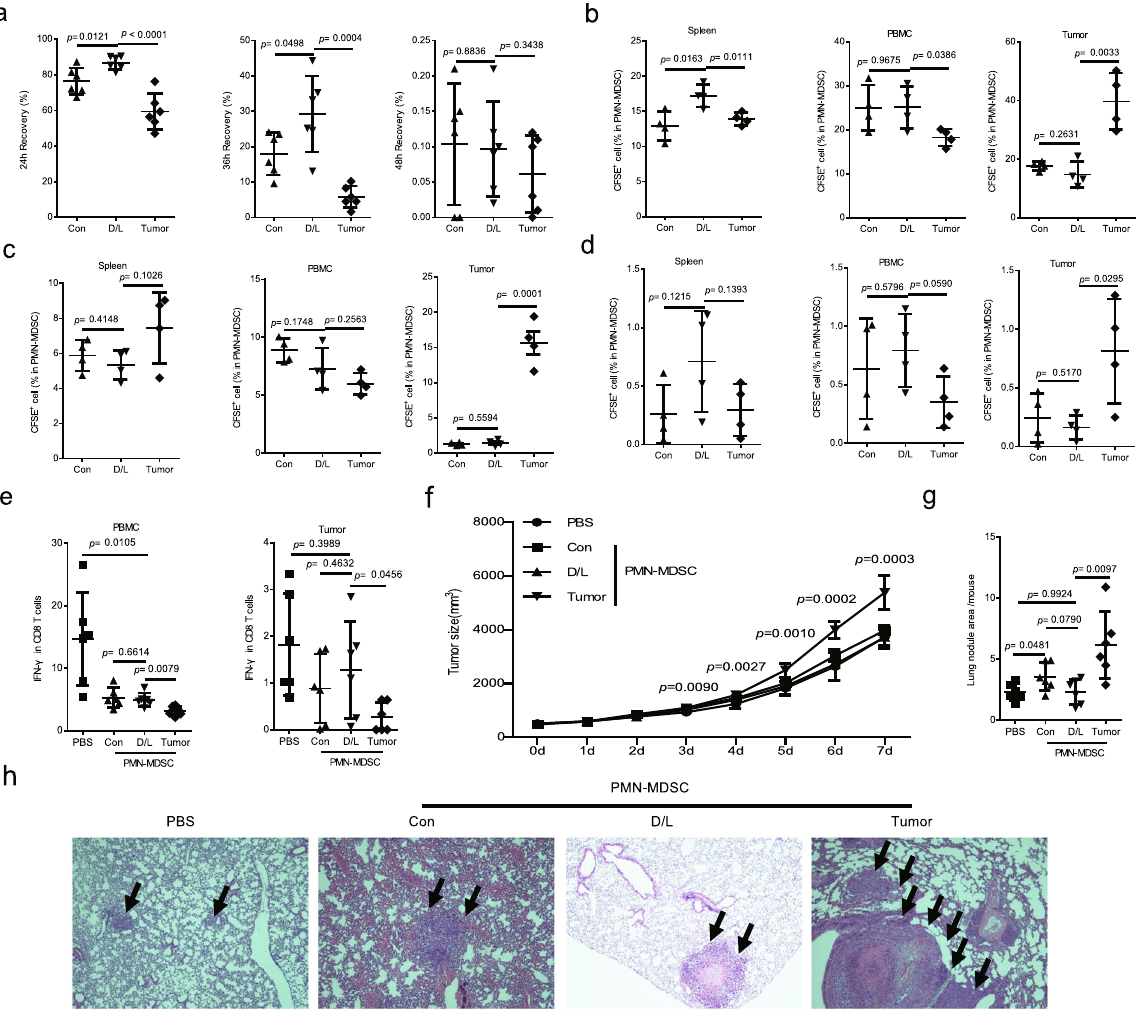
Fig. 4 DXM/lactoferrin PMN-MDSCs presented improved survival capability, less tumor homing tendency and negative tumor promotive effects compared to tumor PMN-MDSCs. a Recovery of PBS (Con) or DXM/lactoferrin (D/L) in vitro from mouse BM cells and PMN-MDSCs from B16 tumor- bearing mice after 24, 36, and 48 h of culture in complete media without cytokines ( n = 6 biologically independent samples). Puri fi ed cells (2 × 10 5 ) were plated at the beginning of culture. Transfer/host PMN-MDSC ratio in spleen, PBMC, and tumor 1 ( b ), 2 ( c ) and 3 ( d ) days after i.v. injection of CFSE- labeled PBS (Con) or D/L in vitro from mouse spleen cells and PMN-MDSCs from B16 tumor-bearing mice into tumor-bearing recipients. Percentages of CFSE-labeled PMN-MDSC are indicated ( n = 4 biologically independent animals). e IFN- γ + cells in CD8 T cells from PBMC and tumor of B16 tumor- bearing mice 24 h after i.v. injection of Con PMN-MDSCs, D/L PMN-MDSCs, and tumor PMN-MDSCs. PBS was used as vehicle control. Tumor growth ( f ) and lung metastasis ( g ) after i.v. injection of Con PMN-MDSCs, D/L PMN-MDSCs, and tumor PMN-MDSCs. h Representative images of hematoxylin and eosin-stained sections of the lungs ( n = 6 biologically independent animals). Error bars displayed the mean and standard